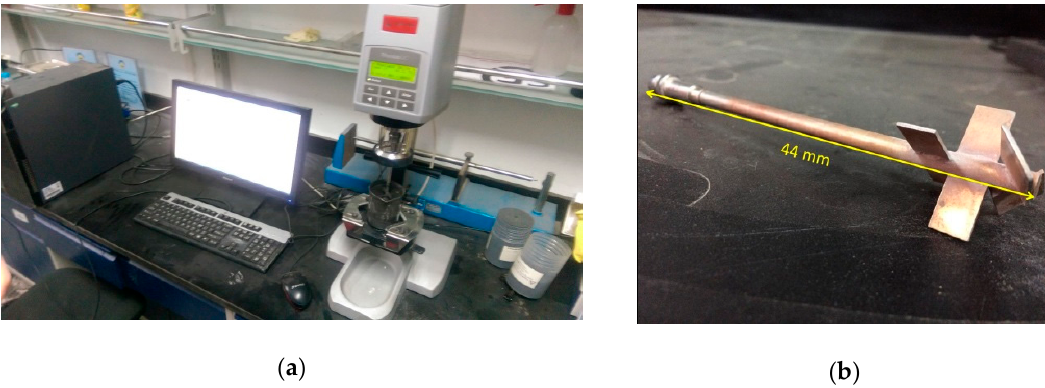
Figure 2. The instruments that uses in the slurry rheological tests: ( a ) and the RheoWin software Rotational rheometer Rheolab QC and RheoWin software (Anton Paar Company Ltd., Ostfildern, Germany); ( b ) six bladed vane rotors.